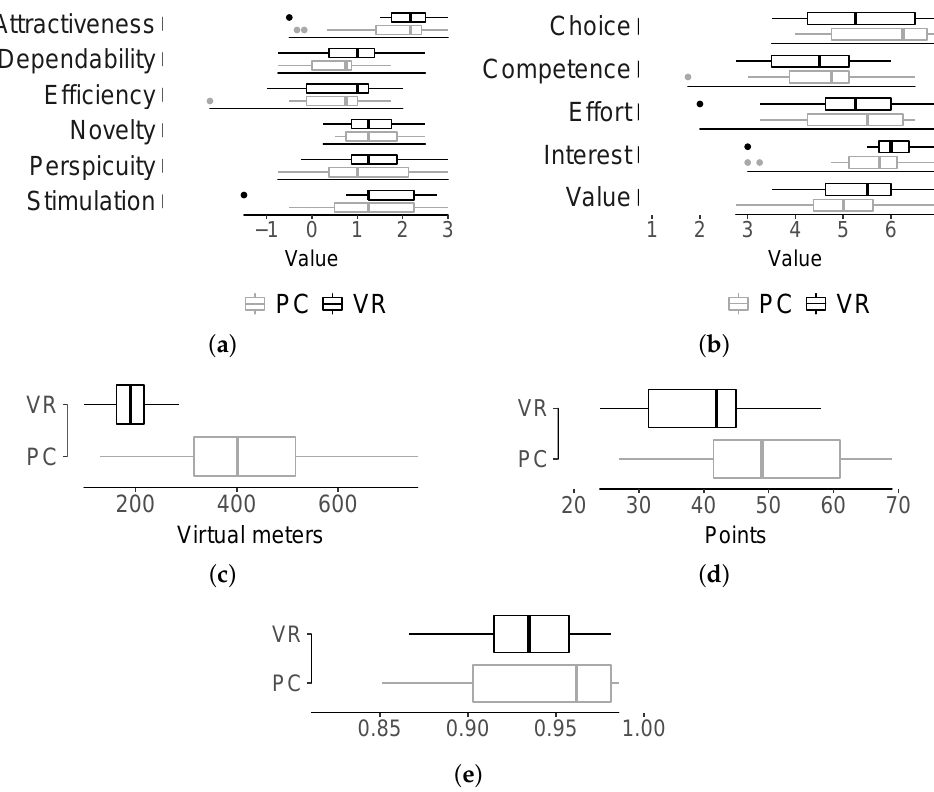
Figure 6. Results from the subjective experiment. The lines inside boxes show the median, first, and third quartiles (hinges), 1.5 times the inter-quartile range left and right the hinges (whiskers), and outlying points. ( a ) UEQ. ( b ) IMI. ( c ) Virtual distance. ( d ) Scores. ( e )